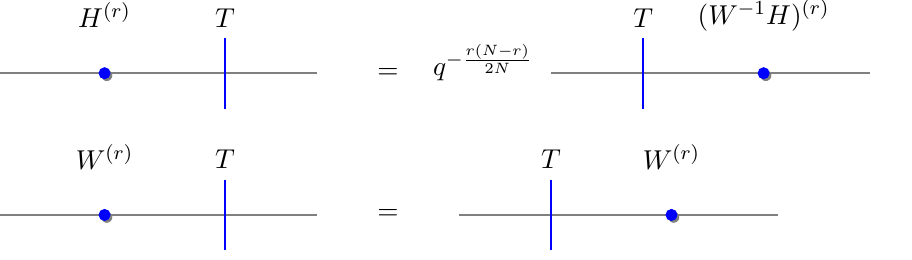
Figure 12 . Translation of a supersymmetric ’t Hooft loop through a T interface generates a supersymmetric mixed Wilson-’t Hooft